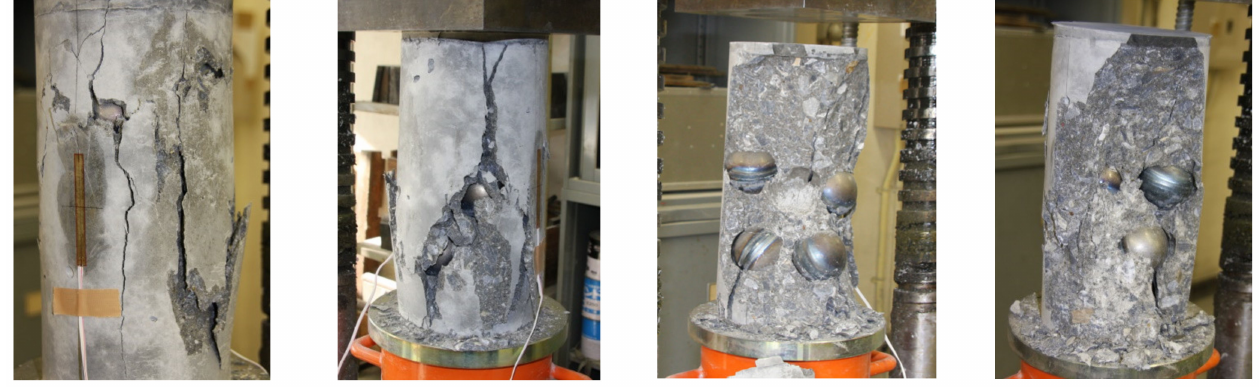
Figure 5. The failure picture of SS